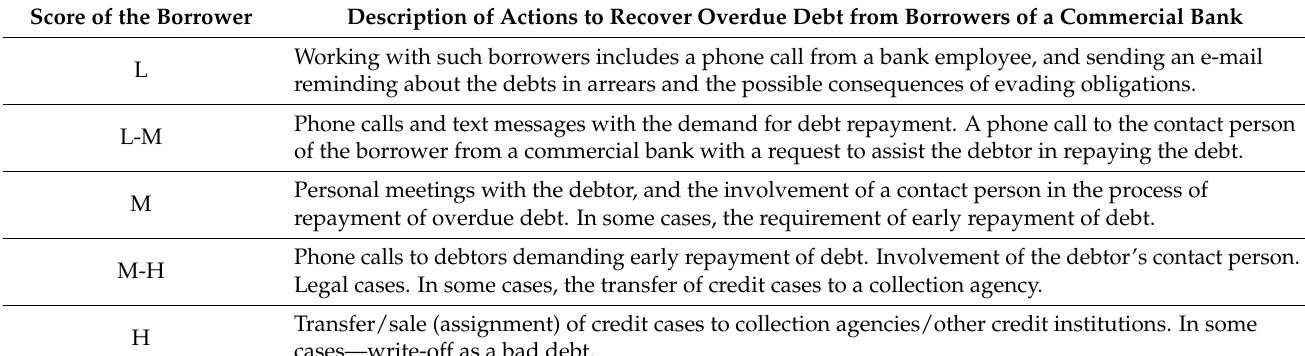
Table 7. Recommendations for managing a problem credit